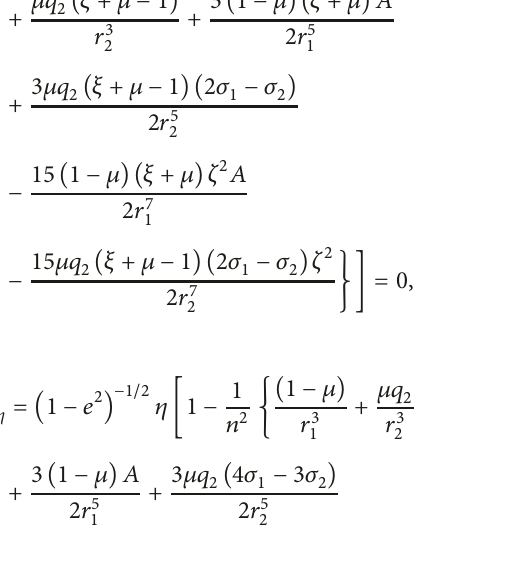
in each row) representation of the curves corresponding to the left frame in each row. In the case of PSR